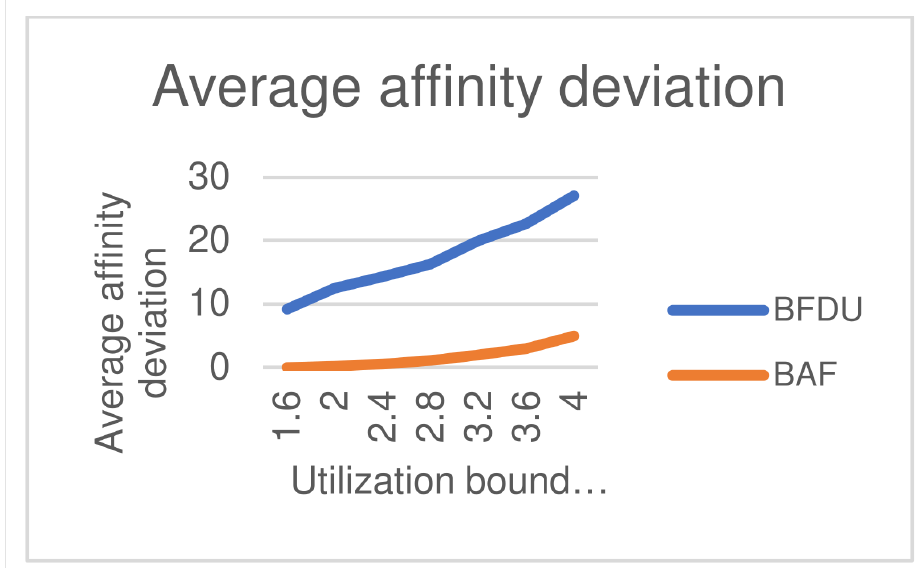
Figure 5. Average affinity deviation by varying the utilization bound. U L = 0.05, U U = 0.75, Z L = 1, Z U =